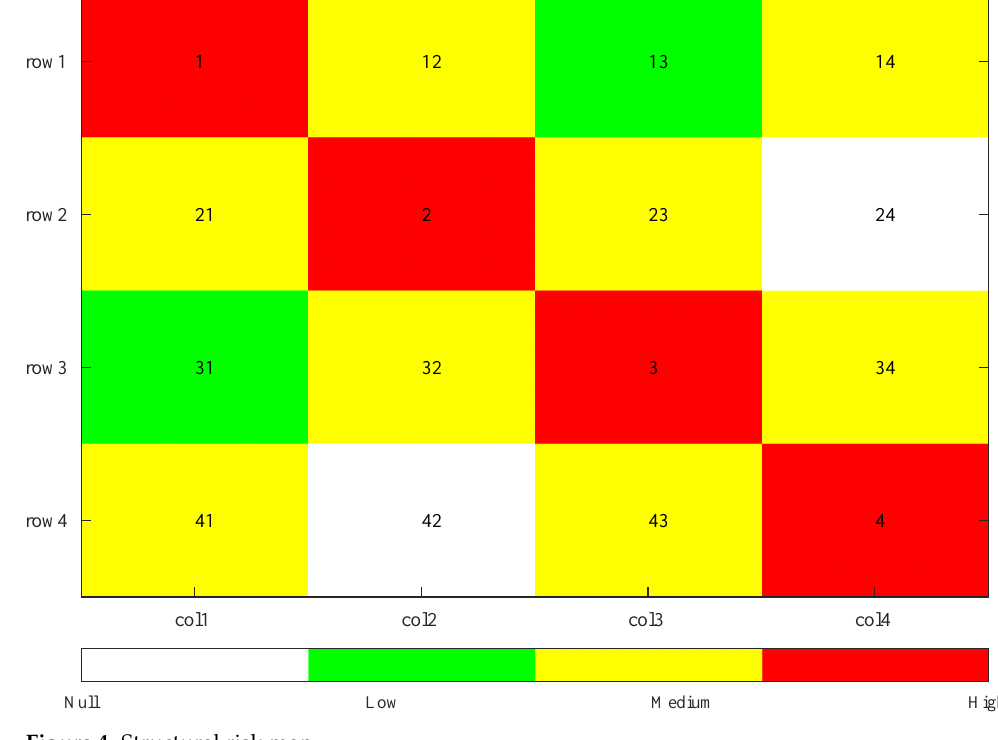
Figure 4. Structural risk